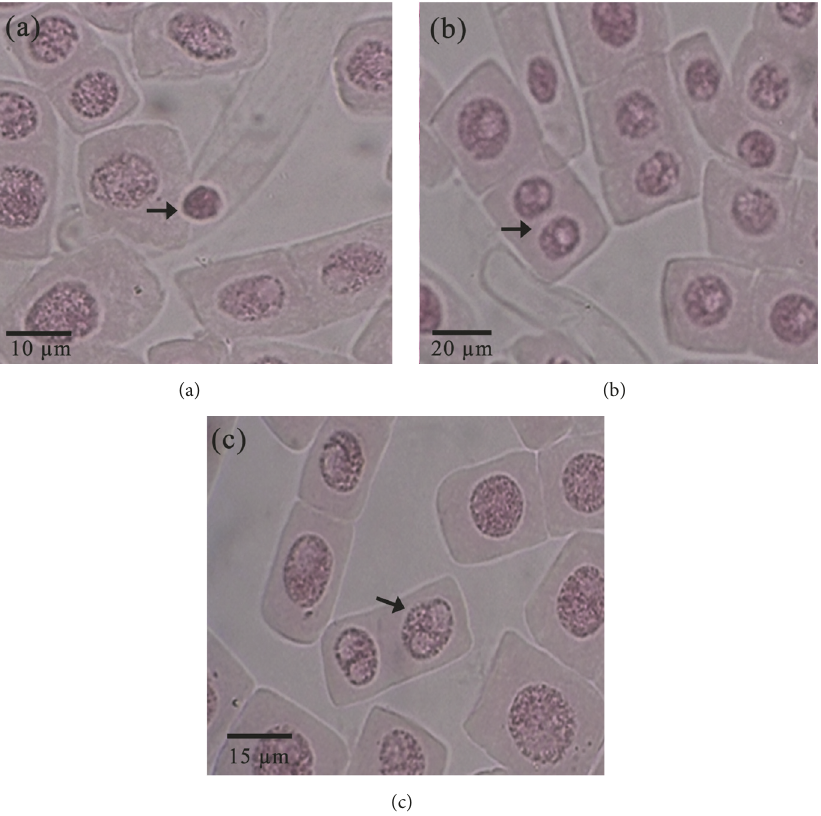
Figure 3: The microscopic appearance of the observed nuclear abnormalities in the Allium cepa rot tip cells ((a): condensed nuclei; (b): bi nuclei; (c): nuclear